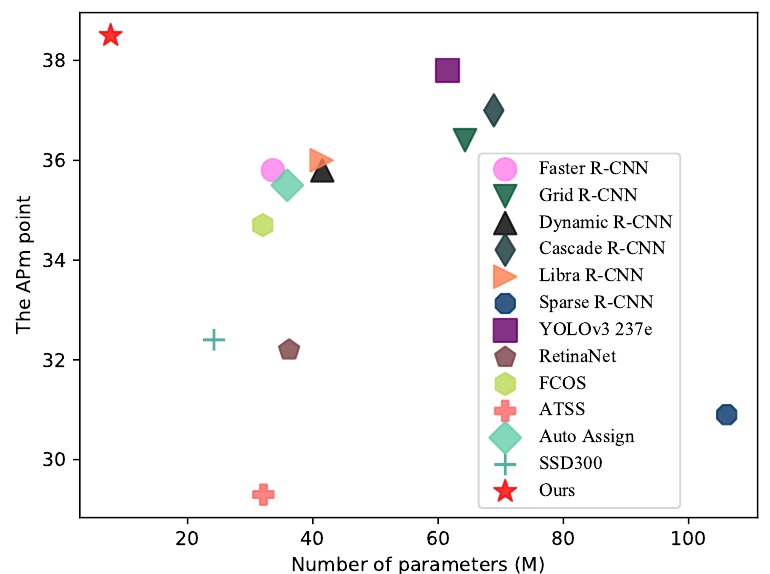
Figure 7. Trade-offs between performance and number of parameters for each model. The x -axis is the number of parameters of the model and the y -axis is the APm point of the model. The closer the model is to the upper left corner, the better the model performs. Our model is represented by a pentagram. Considering both the number of parameters and performance, our model has the best performance among many